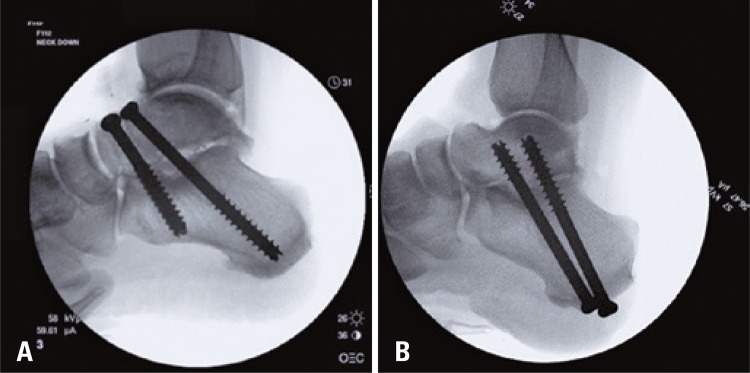
Posicionamento dos parafusos. (A) Orientação dorsal para plantar. Dois parafusos canulados de 7,3mm foram colocados do tálus, posteriormente pelo calcâneo, em direção à superfície plantar. (B) Orientação plantar para dorsal. Dois parafusos canulados de 7,3mm foram colocados do calcâneo em sentido anterior e superior, através do tálus